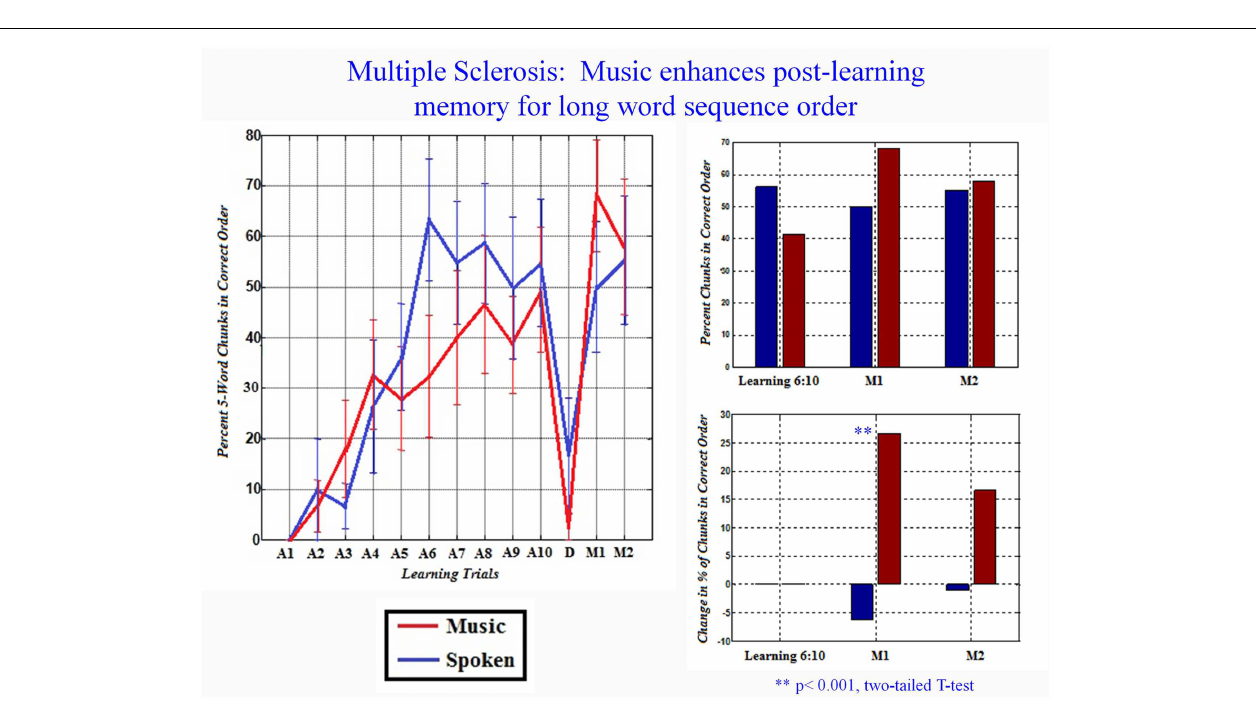
recalled word sequences in correct order ( Y -axis) is the change relative to trial 1. Bars are standard error. Bar graphs on right show % of correct word order for learning trials